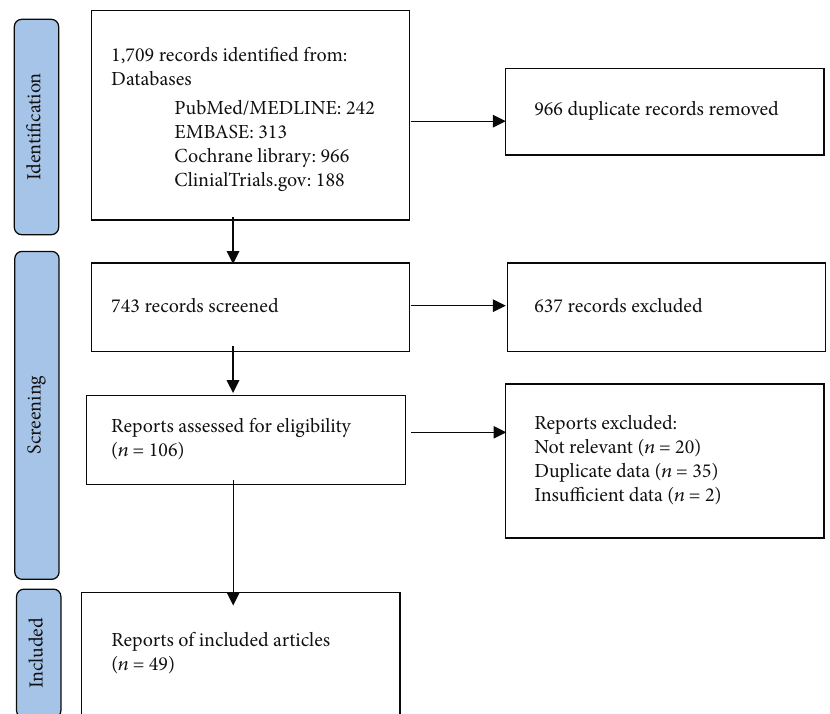
Figure 1: PRISMA fl ow diagram of the process for selection of relevant